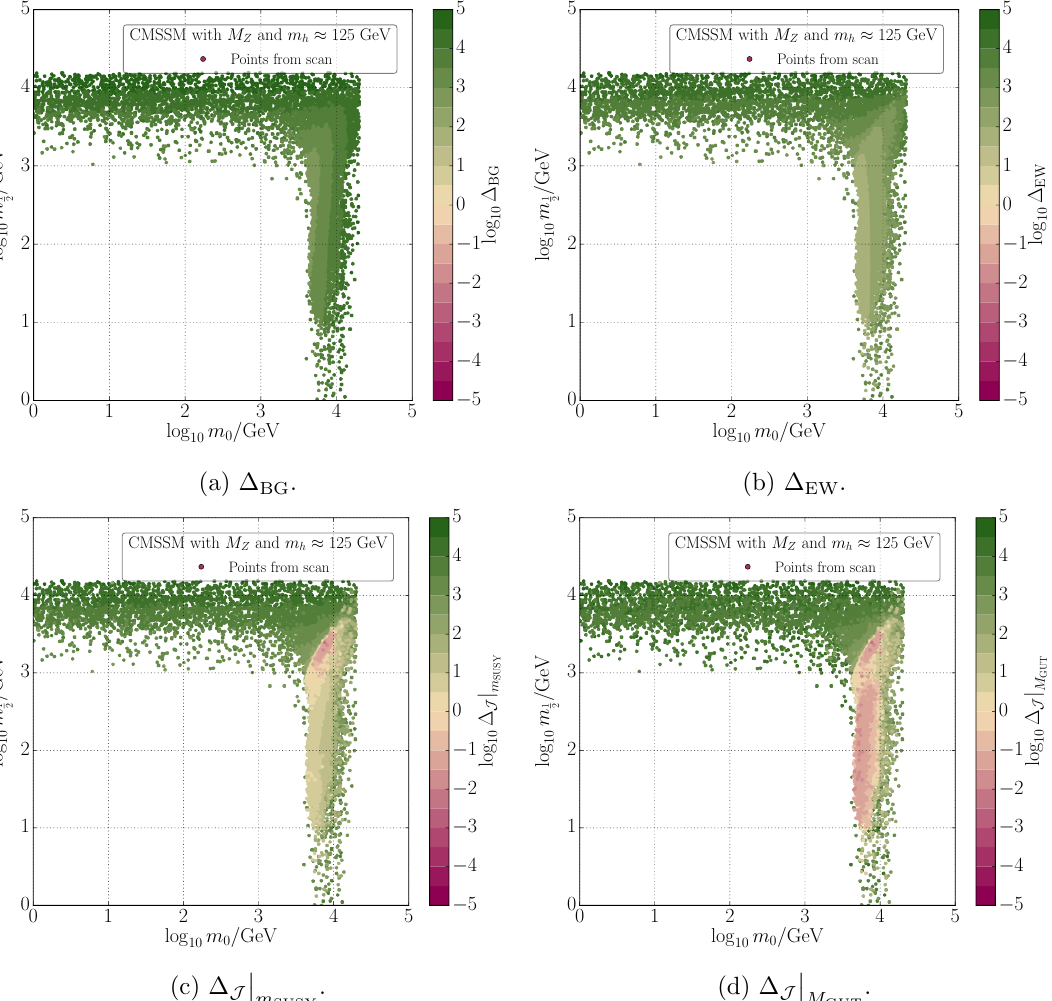
Figure 9. Comparison of (cid:12)ne-tuning measures in the CMSSM with m h m ) plane. For their de(cid:12)nitions, see section 1 = 2